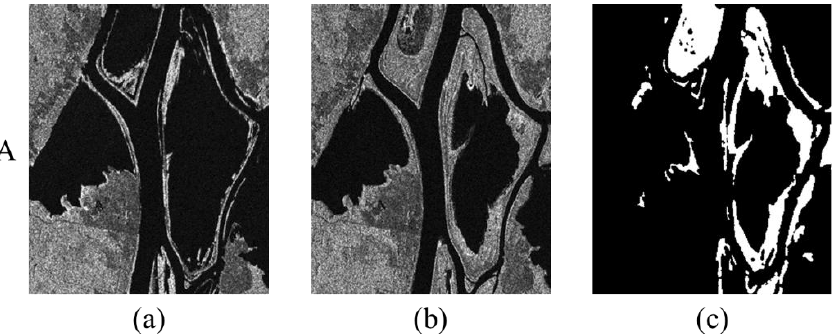
Figure 5. Ottawa dataset. ( a ) Image acquired in July 1997. ( b ) Image acquired in August 1997. ( c ) Ground-truth map.